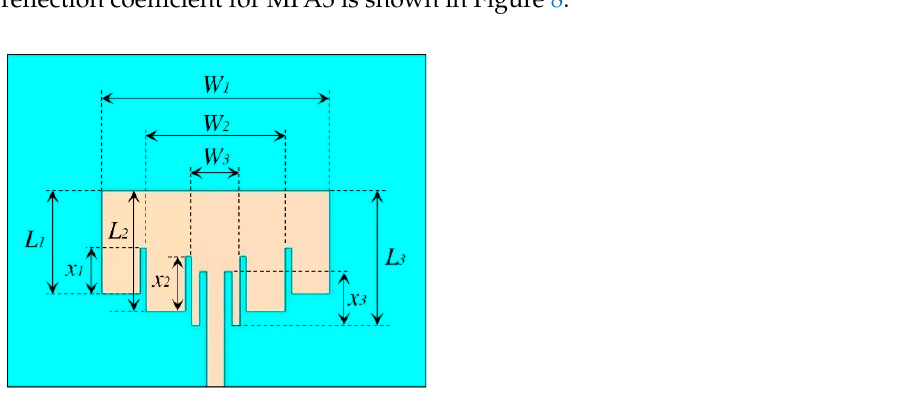
Table 2. MPA3 geometrical parameters.